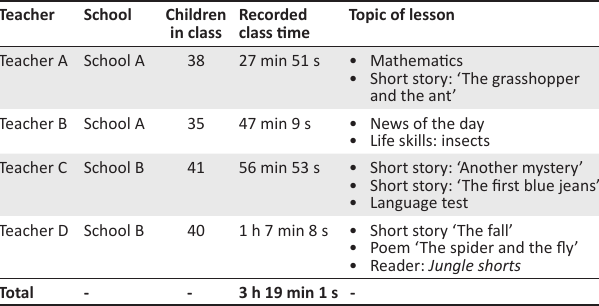
TABLE 1: Overview of recorded